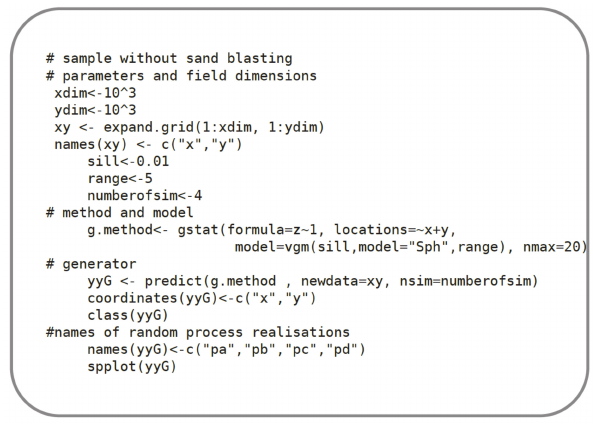
Figure 11. Algorithm No. 2 in R language. Random field generator. (# starts description line).